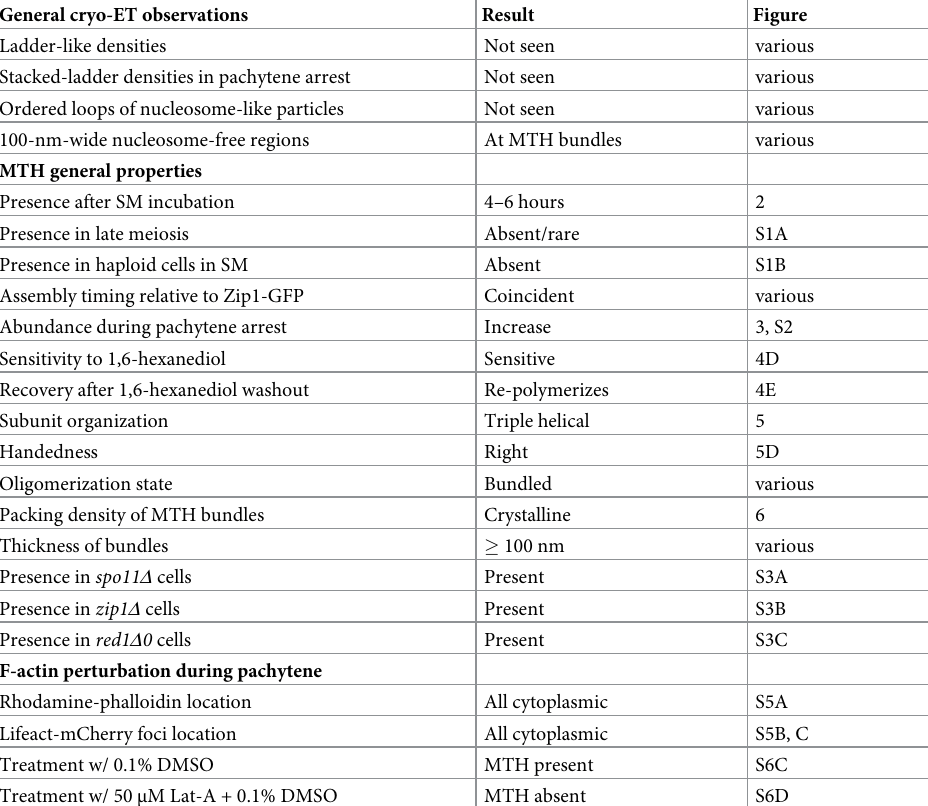
Table 2. MTH detection by cryo-EM. Cell line;